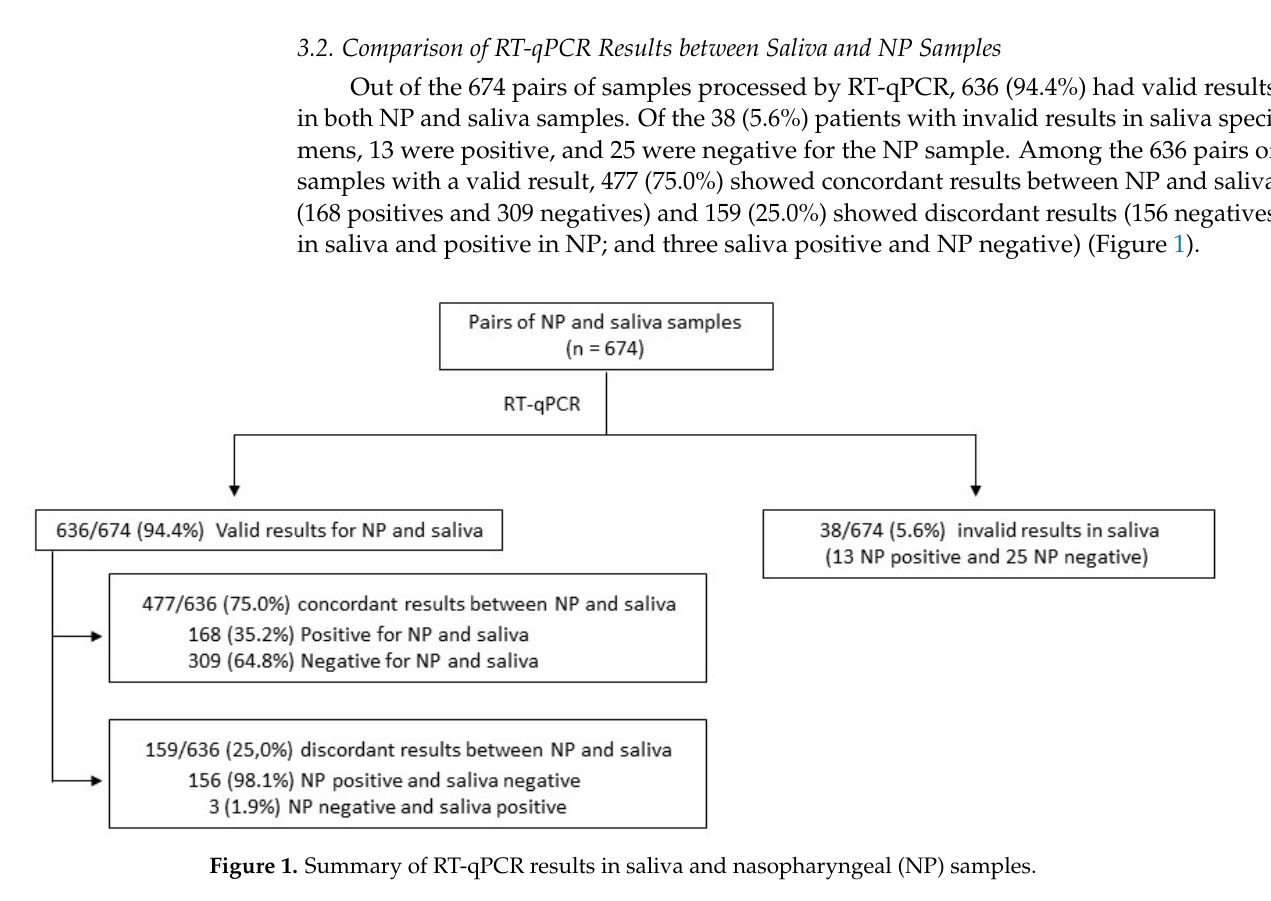
Table 2. Sensitivity (according to Ct and total), specificity, and kappa index of the saliva samples as compared with the result of nasopharyngeal samples.